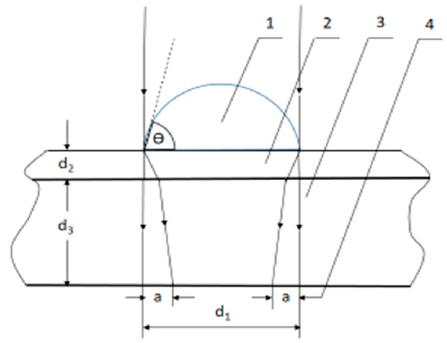
Figure 8. Operating principle of the method for measurement of wetting angle of liquid drops on a hard surface: 1—drop, 2—thin maylar foil, 3—glass plate, 4—refraction ring width. The wetting angle θ is a function of a and d 1 .